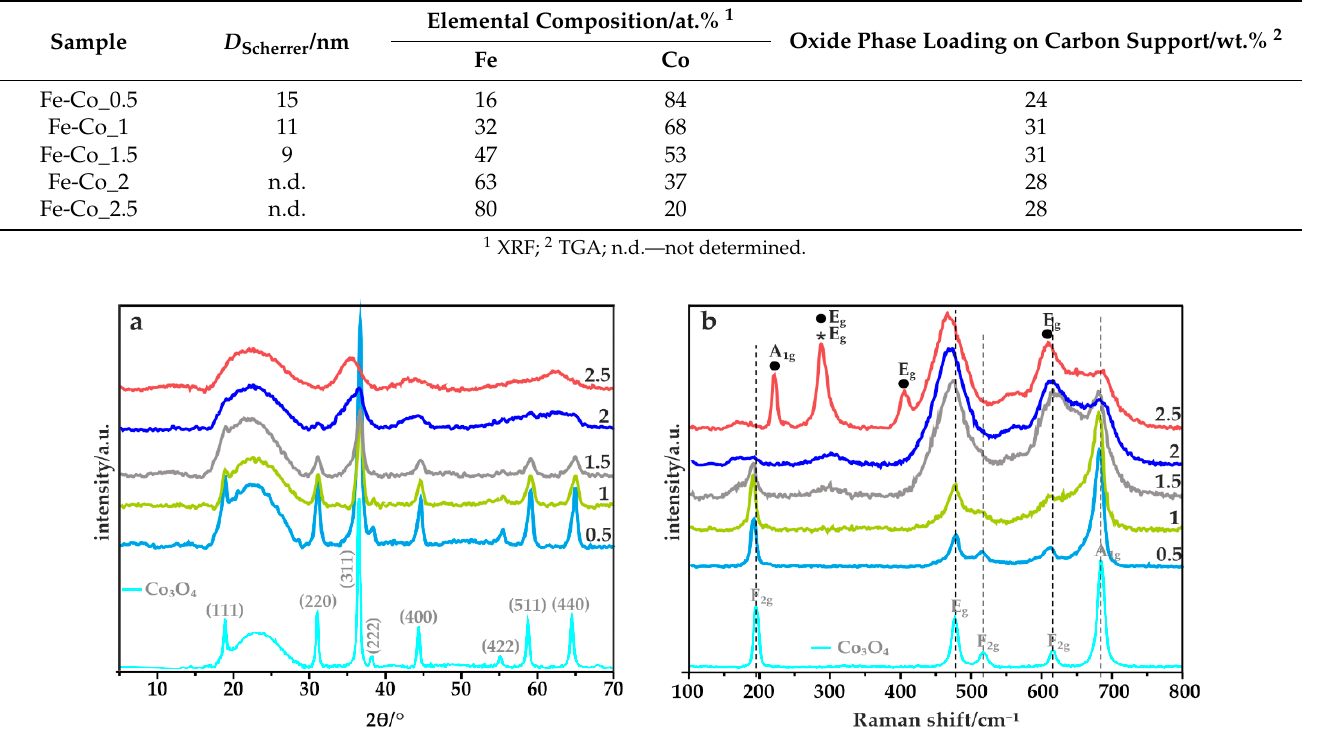
Figure 3. ( a ) XRD patterns and ( b ) Raman spectra of the Fe-Co oxide active phase with different iron content deposited on the N,S-MPC carrier.